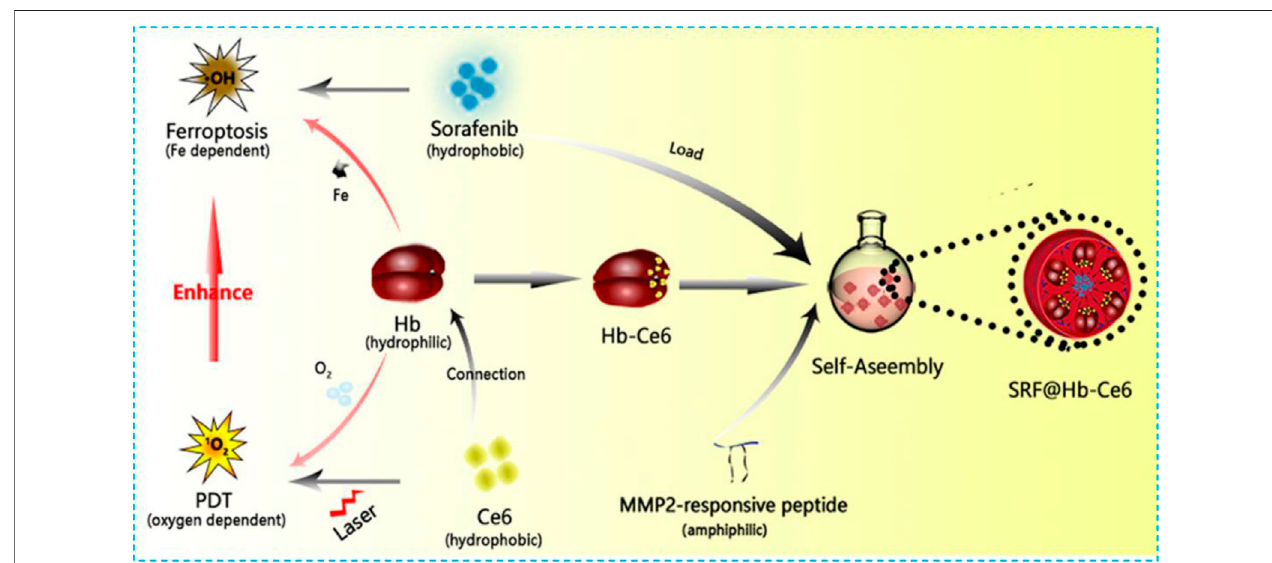
FIGURE 4 | Schematic illustration showing the components of SRF@Hb-Ce6, the synthesis process, and the combined PDT and ferroptosis therapy. Reprinted with permission from Ref. (Xu et al., 2020). Copyright 2020 American Chemical Society.